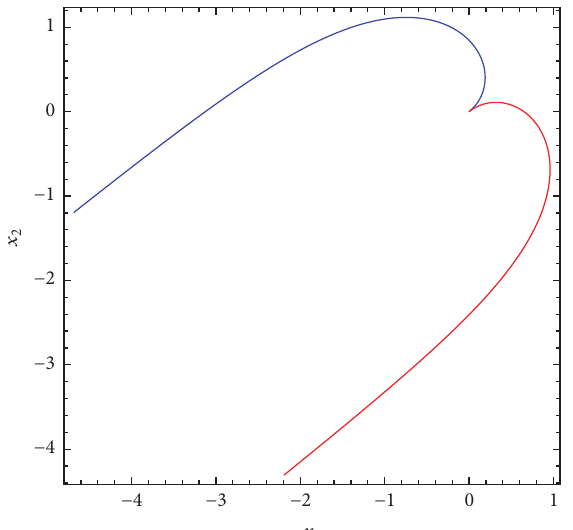
Figure 8: The trajectory of the center of the ball ( (ℎ,𝑐) ∈ Σ 𝑢 2 , 𝑘 = 5 , 𝑙 = 4